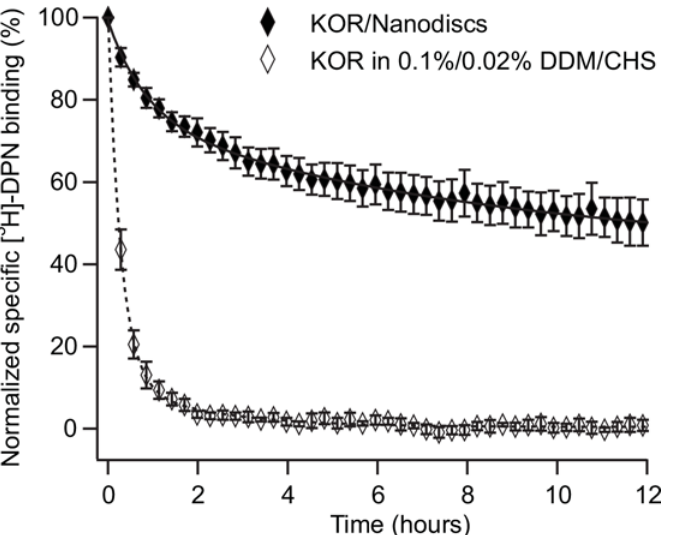
Fig 3. Time-resolved stability of KOR in detergent or when reconstituted in Nanodiscs. Stability of high- affinity ligand binding (10 nM [ 3 H]-DPN (cid:1) 10 x K D ) to KOR in 0.1%/0.02% DDM/CHS (w/v) micelles (open diamonds) or to KOR reconstituted in Nanodiscs (black diamonds) at 23°C. Specific [ 3 H]-DPN binding was normalized to initial ligand binding at time zero where incubation at RT was initiated. Data are average of at least three experiments each performed in triplicates. Error bars represents standard error of the mean. Data were fitted to a double exponential decay curve to calculate the half-life of high-affinity ligand binding to KOR (see Table 1).